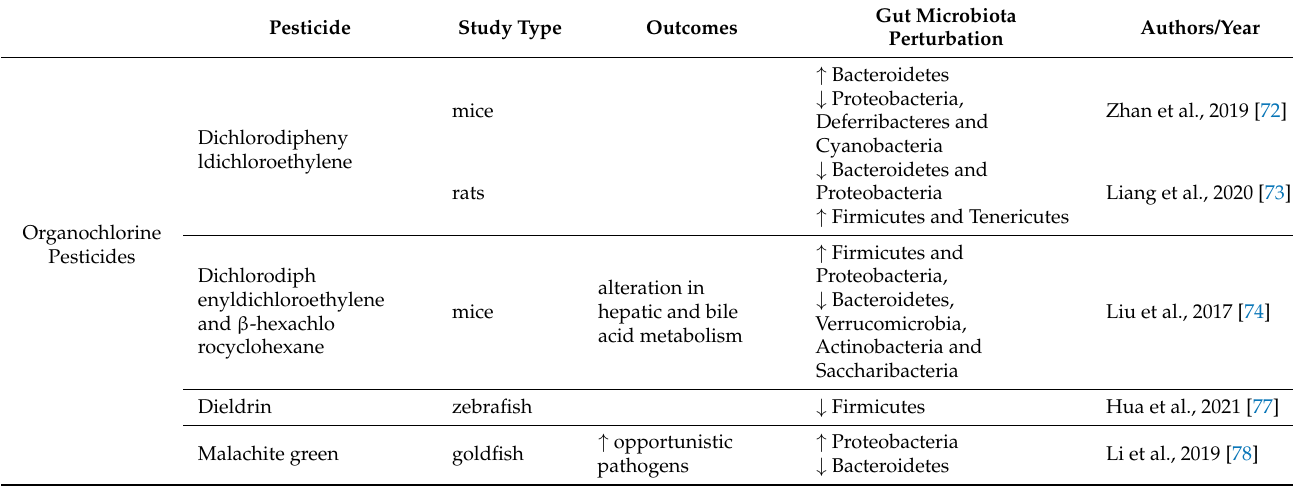
Table A3. Current literature on gut microbiota perturbation due to exposure to organochlorine pesticides.